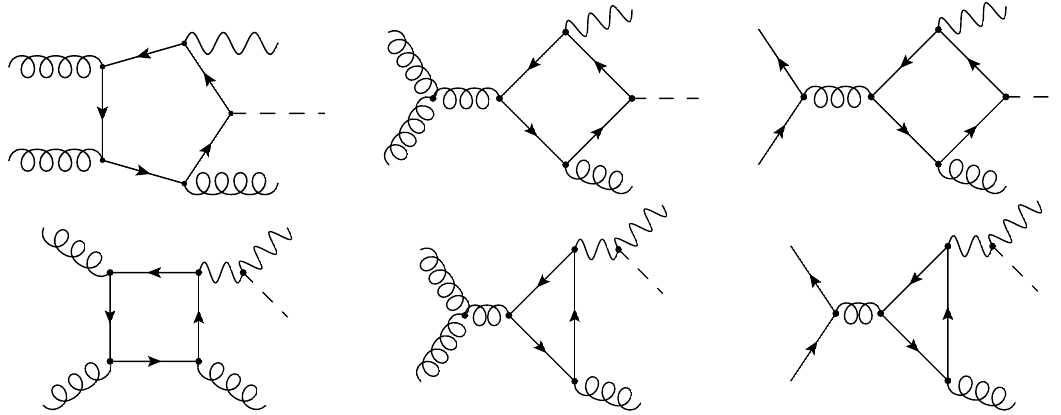
Figure 3. Representative Feynman diagrams for the real correction amplitudes ggZHg and q ¯ qZHg , with n f = 5 massless quarks and a massive top quark running in the closed fermion loops. We calculate in the Feynman gauge and so also include the set of diagrams in which the Z -boson propagators are replaced by Goldstone bosons.